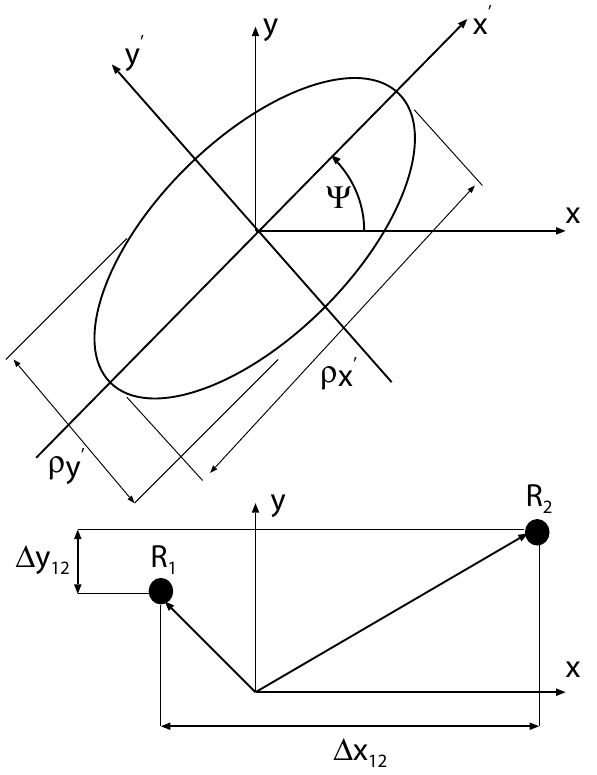
Fig. 1. The upper figure shows the two coordinate systems used. The axes labeled x and y define the ground coordinate system in which baselines are defined and horizontal wind components are measured. The axes labeled x 0 and y 0 define the coordinate system for the ground diffraction pattern and for the refractive index irreg- ularity ellipse parameters ρ x 0 and ρ y 0 . The two coordinate systems are related by the rotation angle 9 . The lower figure shows the components 1x 12 and 1y 12 of an antenna baseline between two receiver antennas denoted by R 1 and R 2 , in the ground coordinate system. For spaced antenna observations, three such baselines are defined between three non co-linear receiver